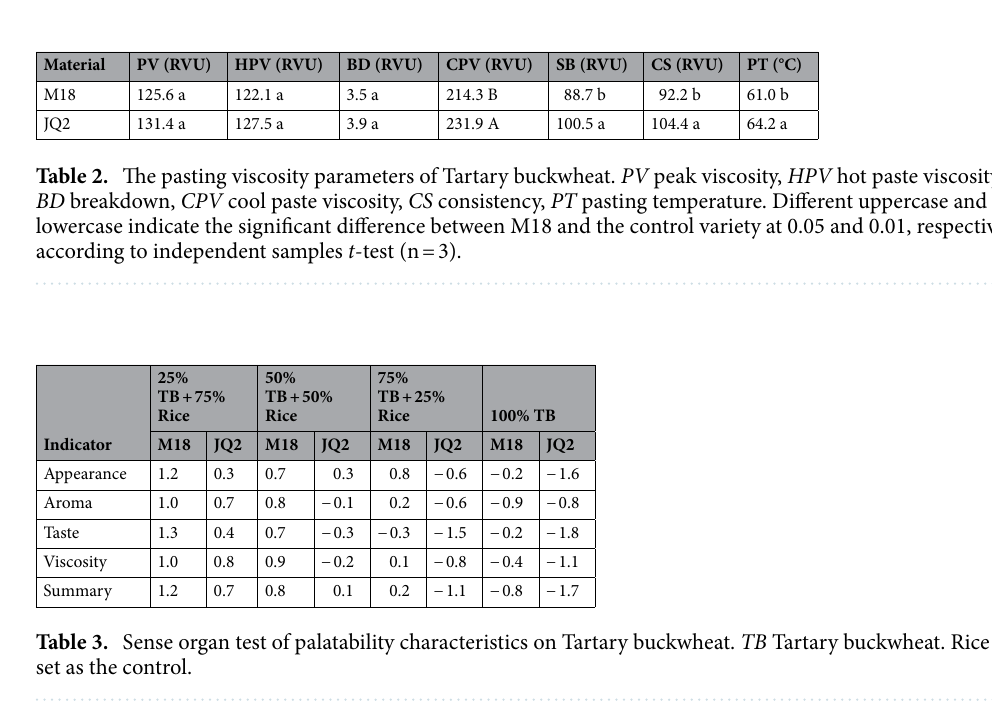
Table 1. Agronomic analysis of M18 planted in 2018 and 2019. Different uppercase and lowercase indicate the significant difference between M18 and the control variety at 0.05 and 0.01, respectively, according to one-way ANOVA.